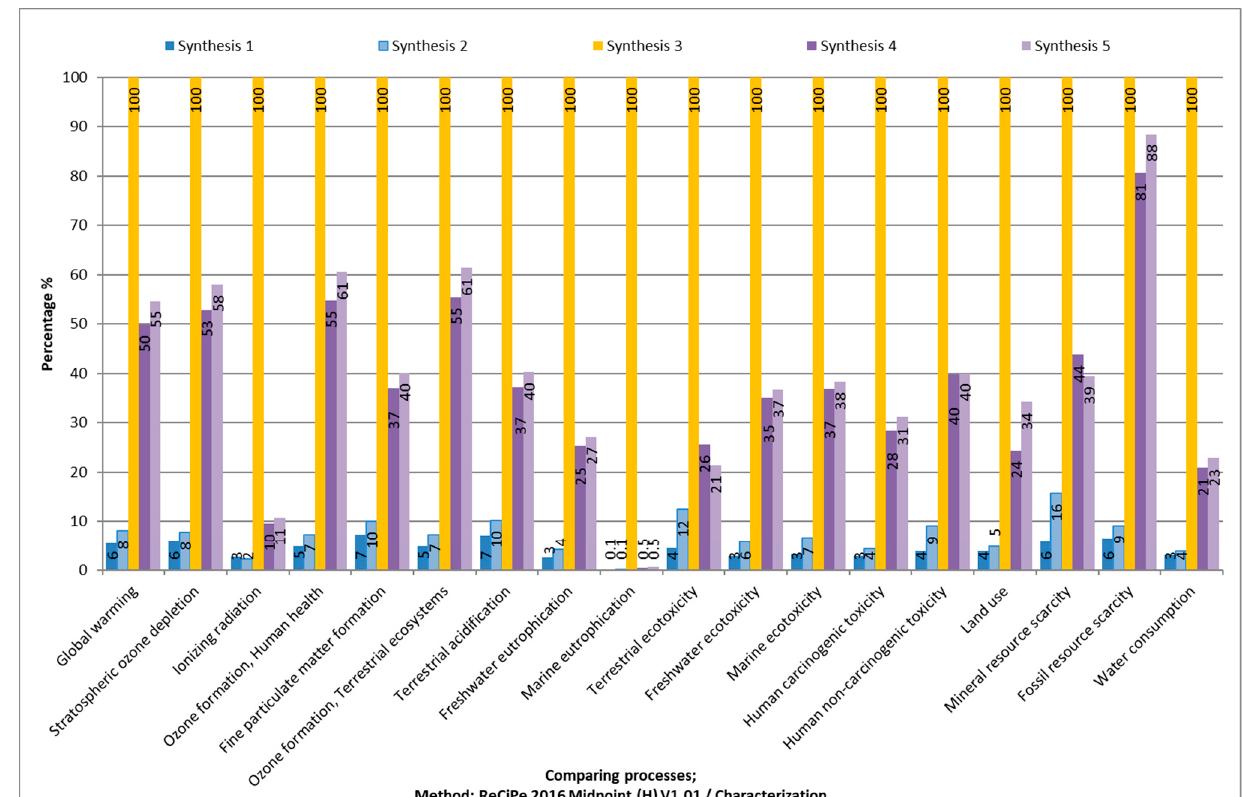
Figure 2. Comparative damage assessment of the five synthetic routes of ZIF-8.